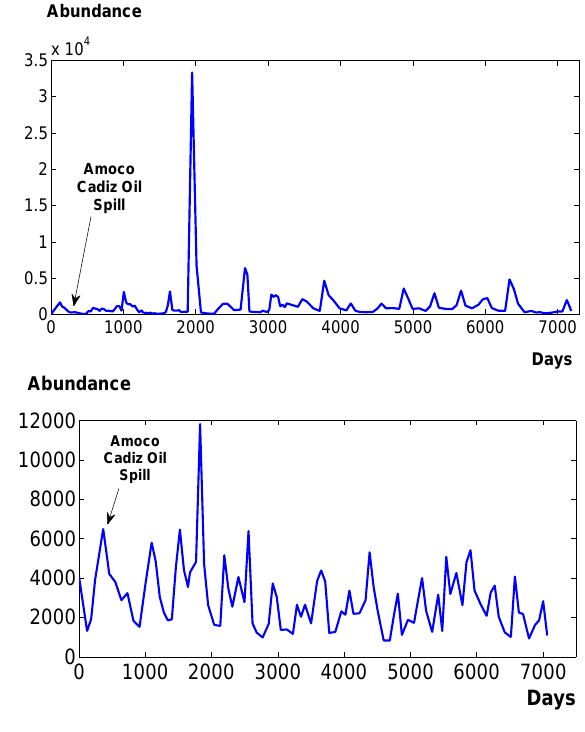
Fig. 2. Variations of polychaete abundance in (a) Pierre Noire site (above) and (b) Riviere de Morlaix site